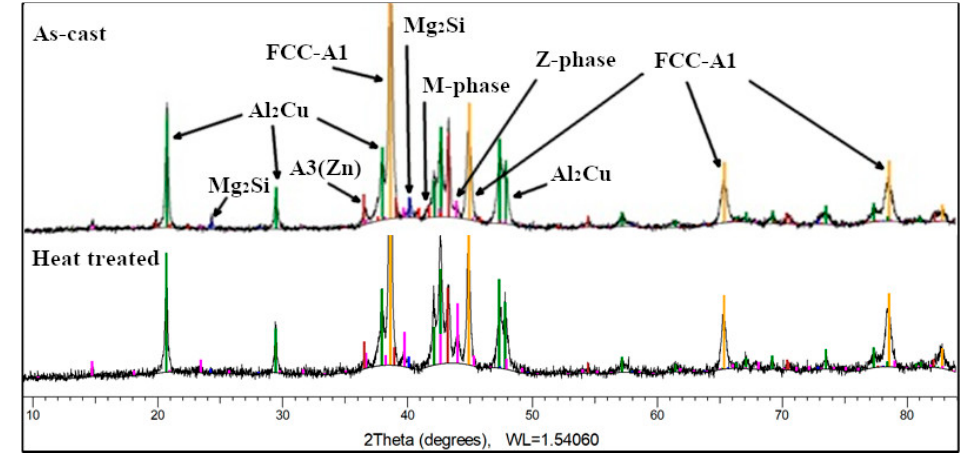
Figure 20. XRD results for as-cast and heat treated Al 3.4 Cu 0.5 Si 0.2 Zn 0.5 Mg 0.2 alloy.